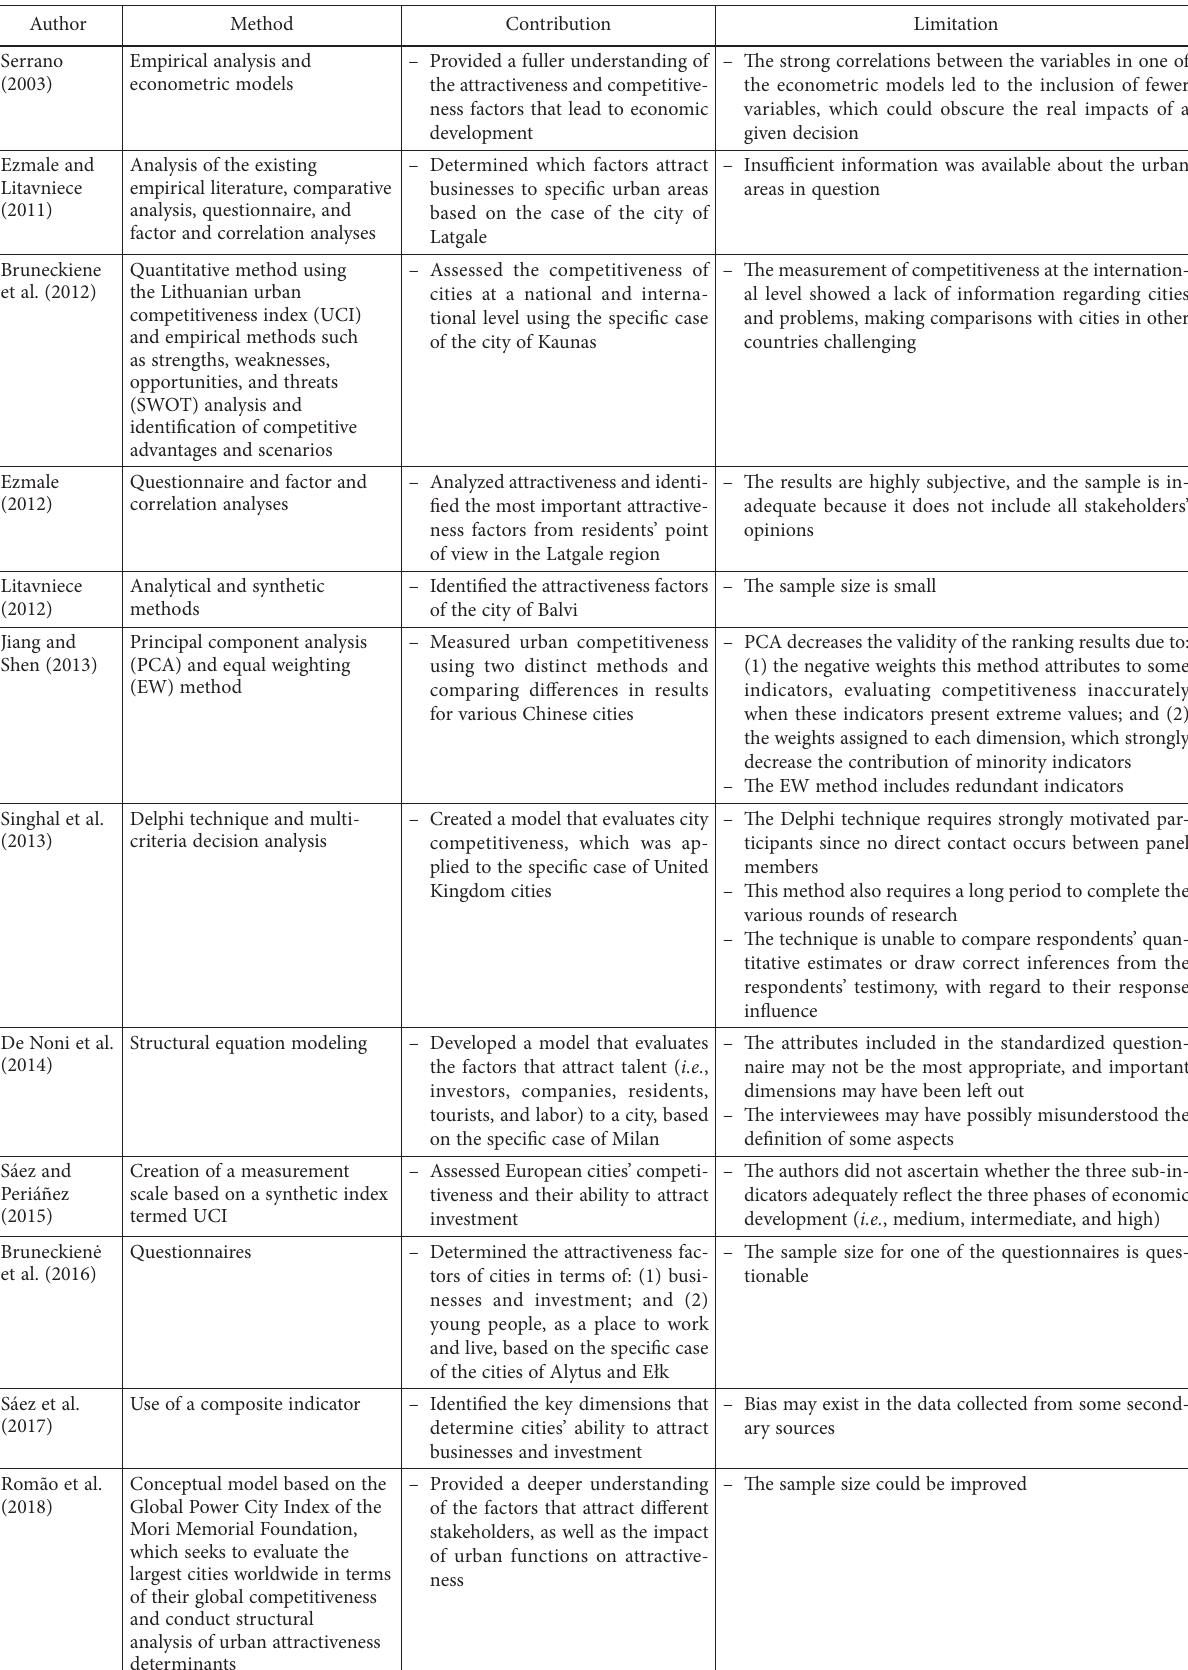
Table 1. Methods of evaluating factors influencing urban investment